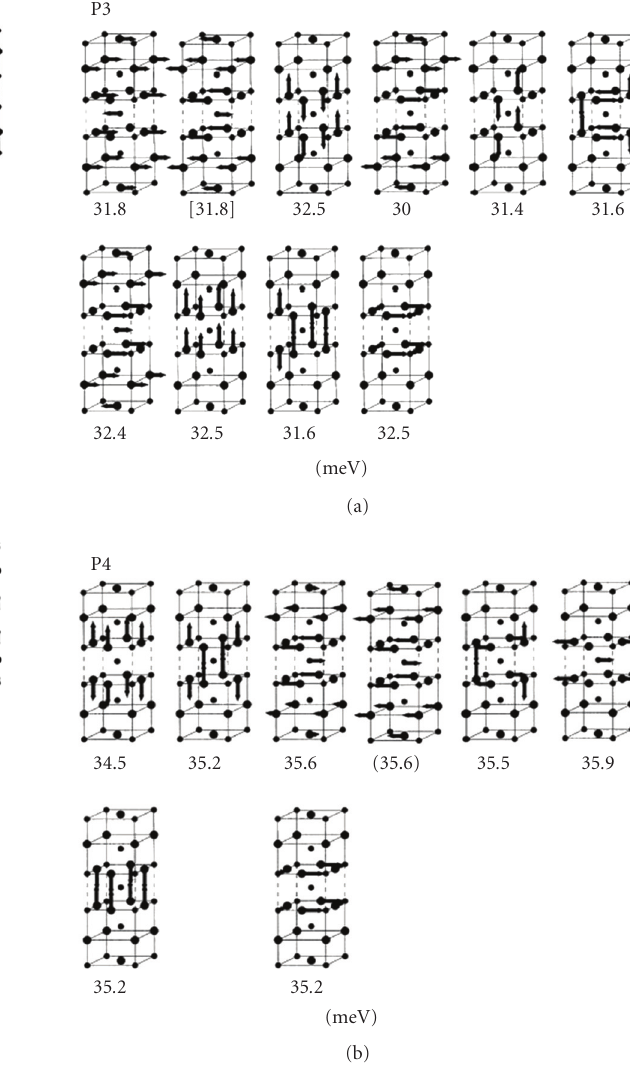
Figure 27: Atomic polarization vectors and their frequencies (in meV) at special points in the Brillouin zone. The larger closed circles in the lattice are O-ions. Γ − X is along the Cu-O-Cu direction. Arrows indicate displacements. The modes in square and round brackets are the transverse and longitudinal optical modes, respectively. (a) Modes of the P3 peak. (b) Modes of the P4 peak. From [46, 47, 53,